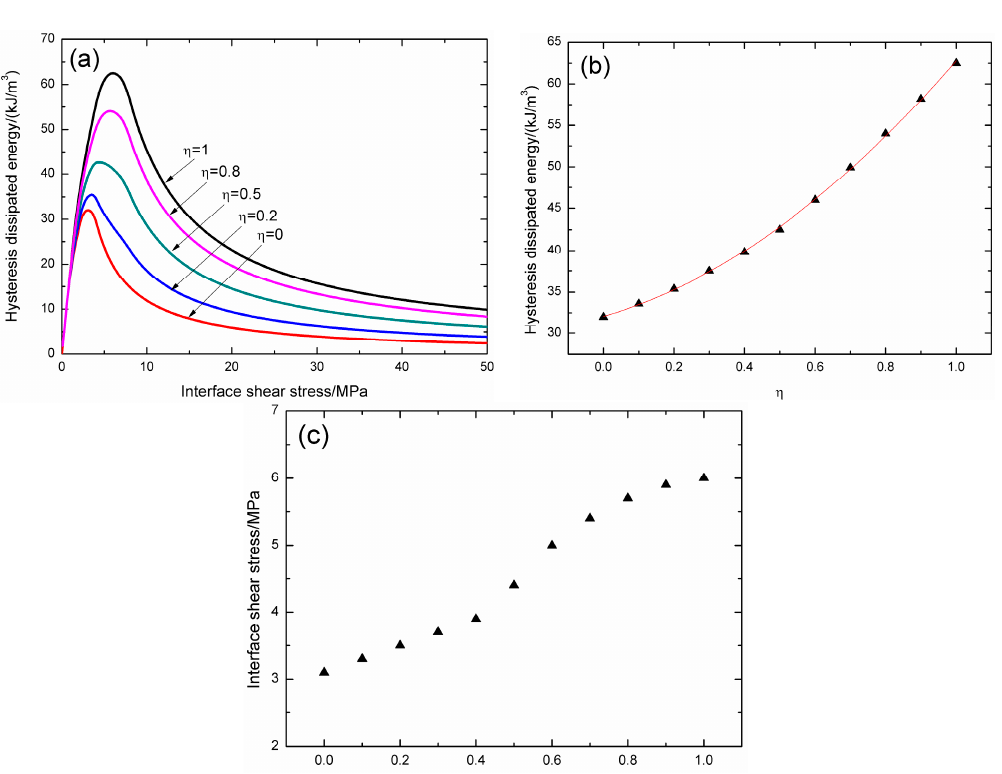
Figure 5. Effect matrix cracking mode proportion, i.e., η = 0, 0.2, 0.5, 0.8 and 1.0, on ( a ) the hysteresis dissipated energy versus interface shear stress curve; ( b ) the peak value of composite hysteresis dissipated energy versus η curve; and ( c ) the corresponding interface shear stress versus η curve.